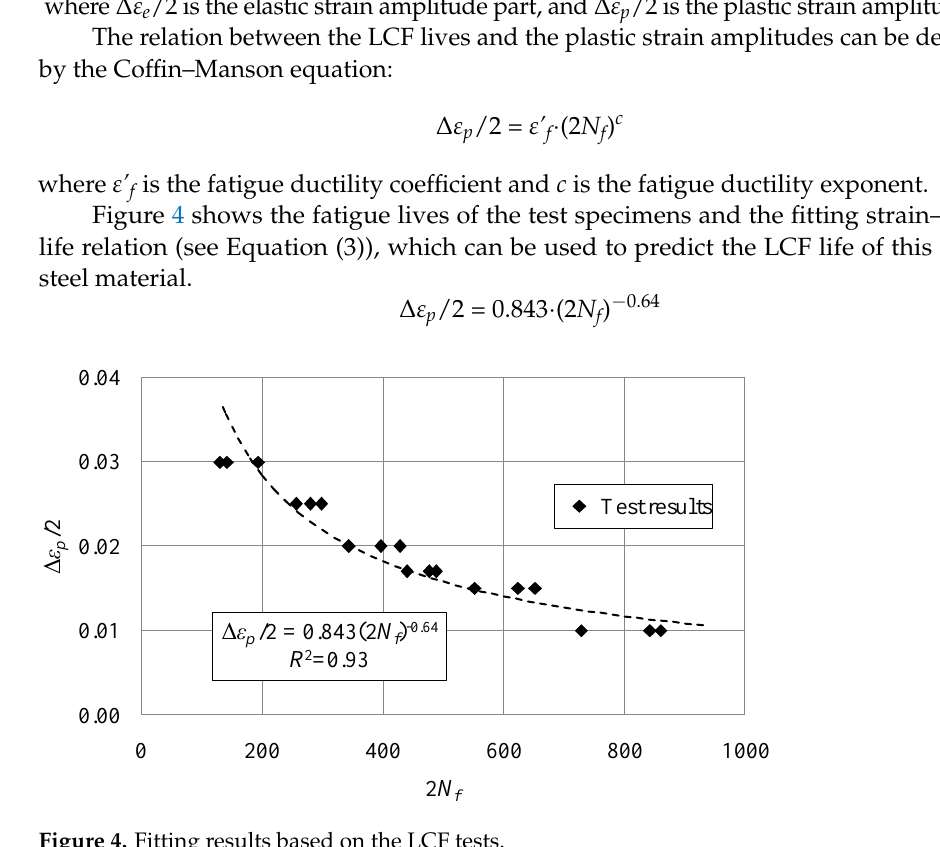
Figure 4. Fitting results based on the LCF tests.